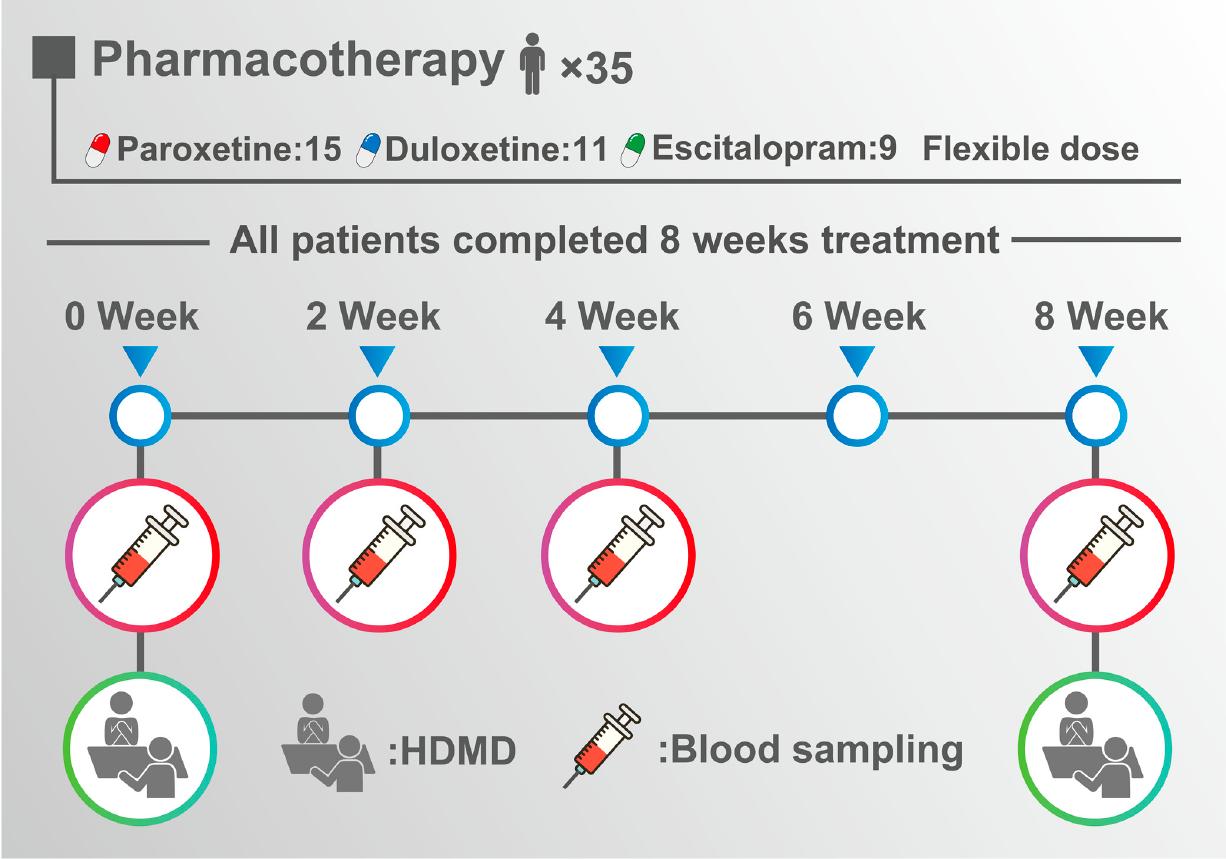
Figure 1. Study protocol.